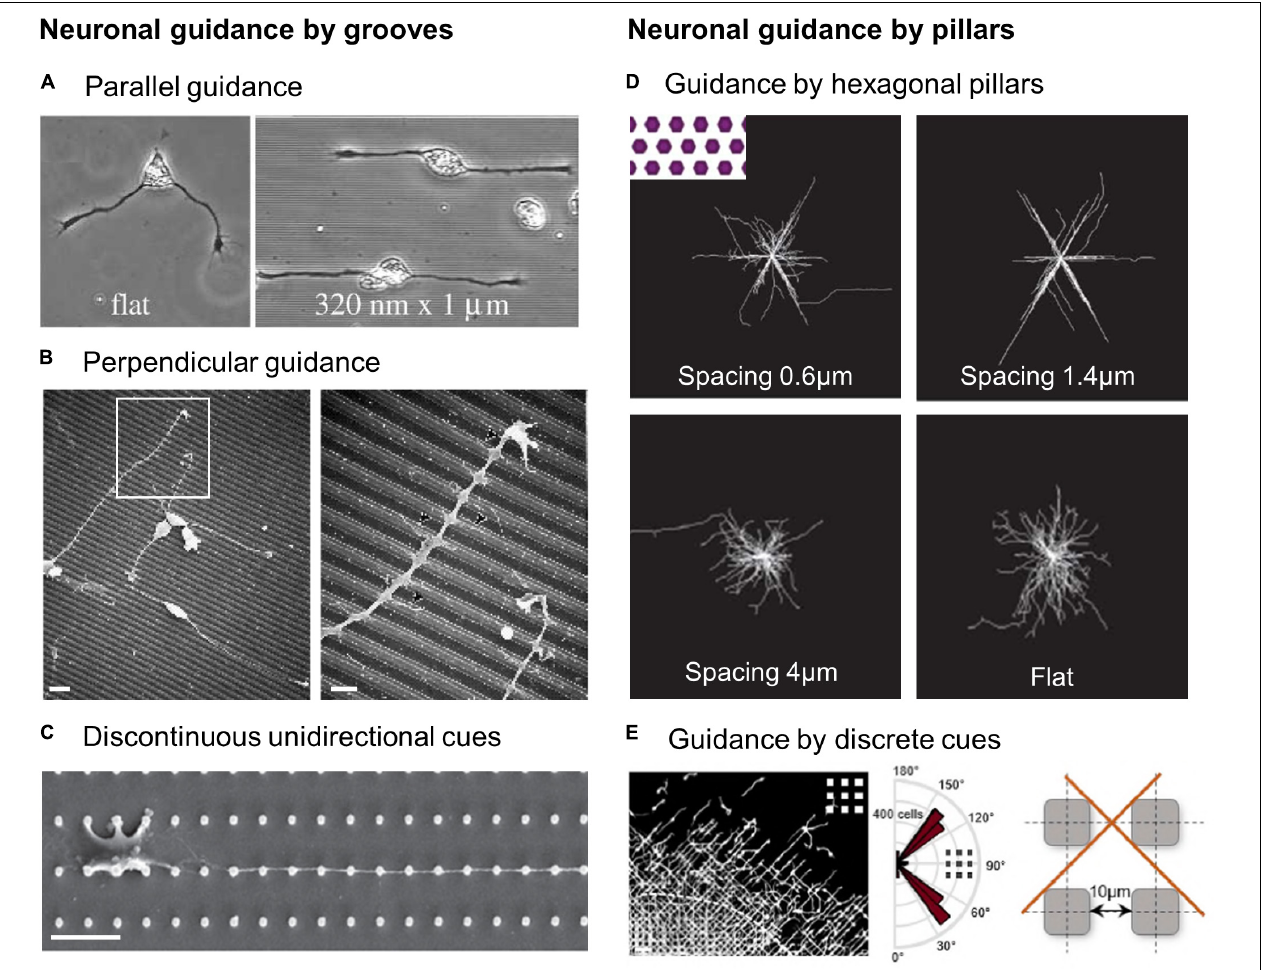
FIGURE 3 | Guidance of neuronal cells by microstructured substrates. (A) Xenopus spinal cord neurons on flat or 1 µ m wide, 320 nm deep grooves. Reproduced with permission from Rajnicek et al. (1997). (B) Scanning electron microscopy (SEM) images of cortical neuroblasts on grooves (1 µ m width, 0.5 µ m depth). Scales 5 µ m (left), 2 µ m (right). Reproduced with permission from Nagata et al. (1993). (C) SEM image of a primary hippocampal neurons on unidirectional micropillars array. Scale 10 µ m. Reproduced with permission from Park M. et al. (2016). (D) Hippocampal neurons alignment on flat or in between hexagonal pillars of various spacing. Reproduced with permission from Kundu et al. (2013). (E) Alignment of migrating cortical interneurons in between square pillars. Scale 50 µ m. Reproduced with permission from Leclech et al. (2019).